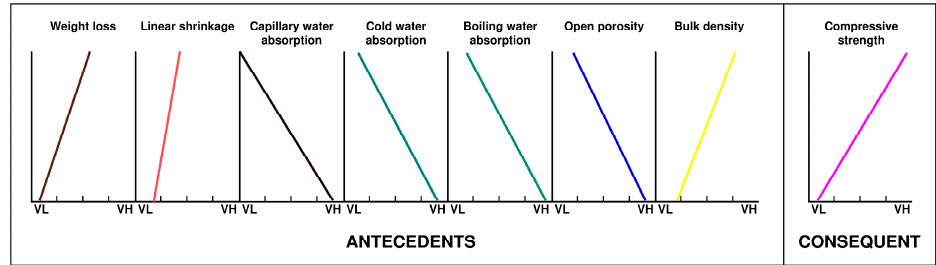
Figure 4. Trending lines of the different variables throughout the discourse universe for each of the 4 fuzzy rules from the “centers of gravity” of the figures corresponding to the values “extreme-high” and “extreme-low”.